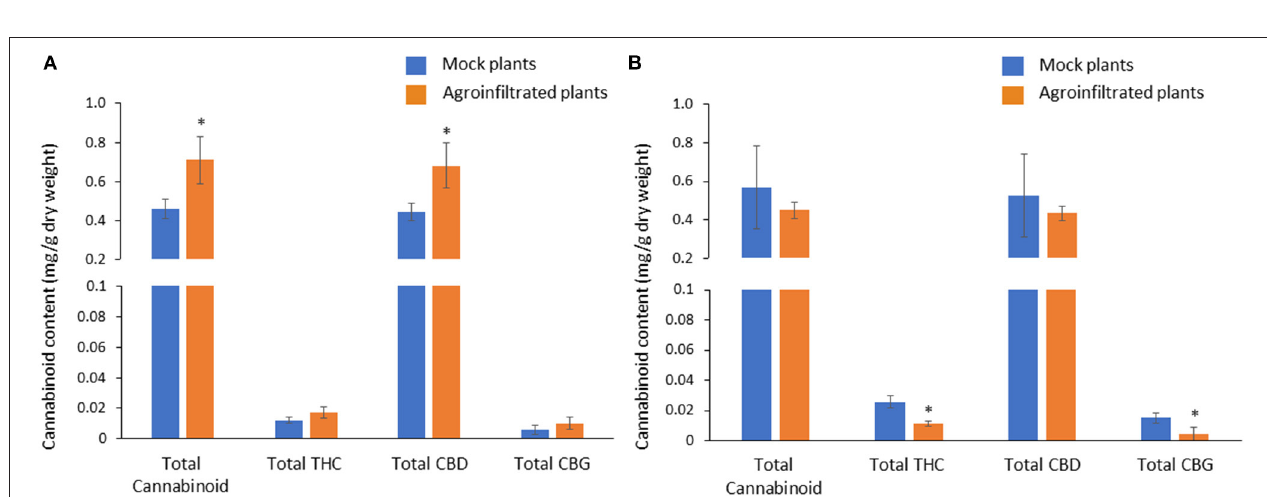
FIGURE 6 | Gene expression profiles of CBDAS and THCAS in CBDAS overexpressed female flowers (A) and THCAS silenced female flowers (B) . Data is presented as mean ± S.E. * and ** indicates statistically significant differences at P < 0.05 and P < 0.01, respectively, compared with mock plants, according to the statistical analysis in paired t -tests.